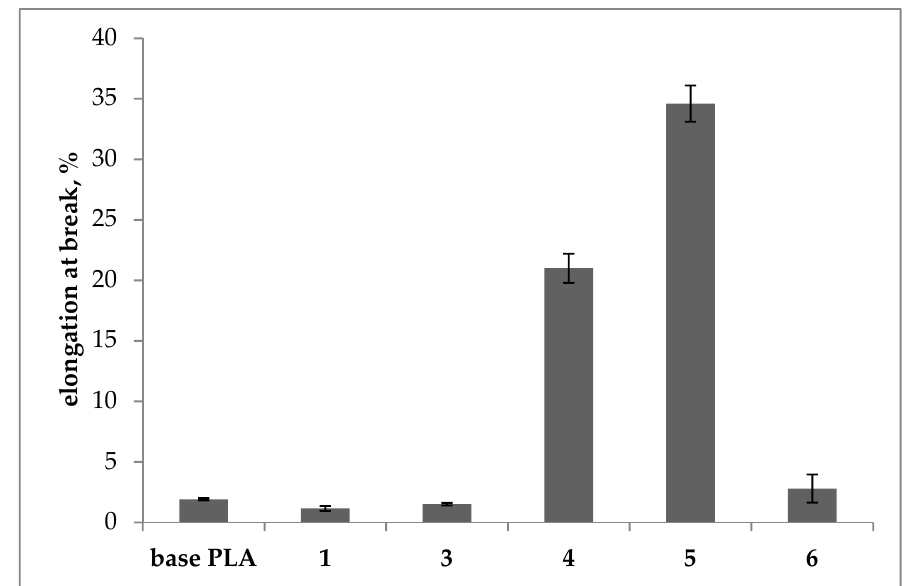
Figure 8. Elongation at break of the base and plasticized PLA filaments.